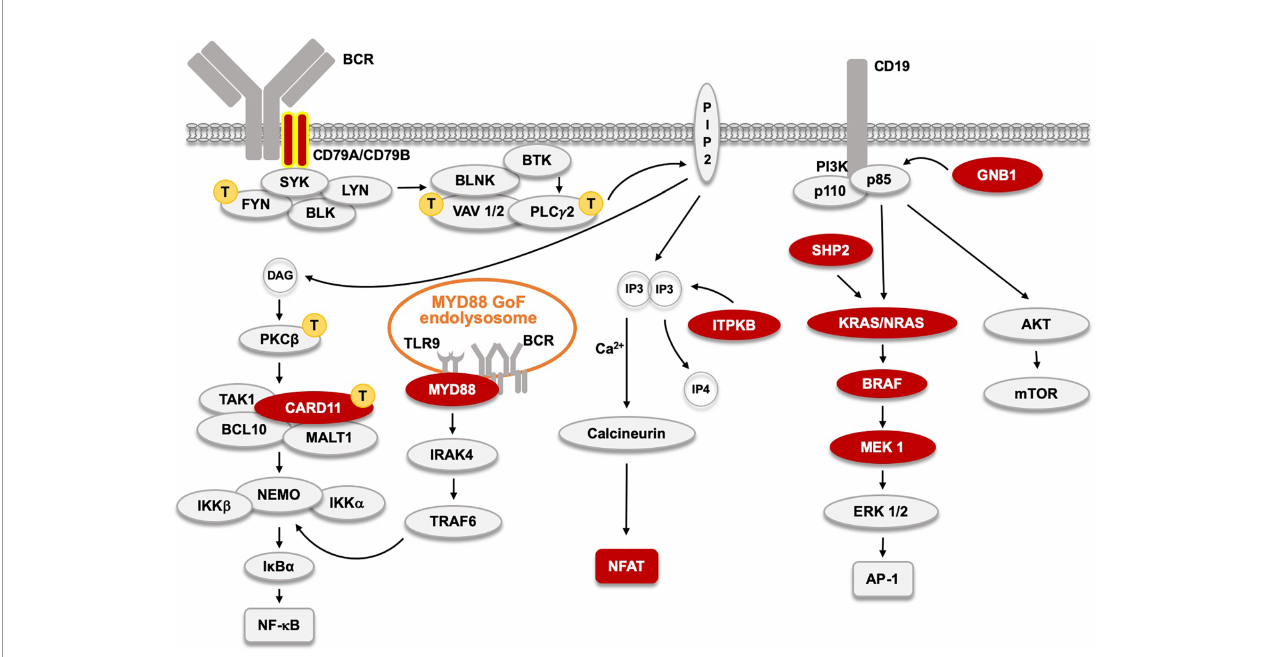
FIGURE 3 | The B cell receptor (BCR) signaling pathway and acquired, primary, driver Gain-of-Function (GoF) mutations found in CLL and other BTKi-sensitive malignancies . CD79A and B GoF, found in WM and ABC-type DLBCL, and very rare in CLL, are labeled with yellow contour. Signaling proteins marked with indicate those affected by primary GoF mutations in adult T cell leukemia as reported (103). The MYD88 L265P GoF mutation in 95% of WM patients, and also in ABC-type DLBCL, and in some CLL patients induces an activated endolysosome containing TLR9 and the